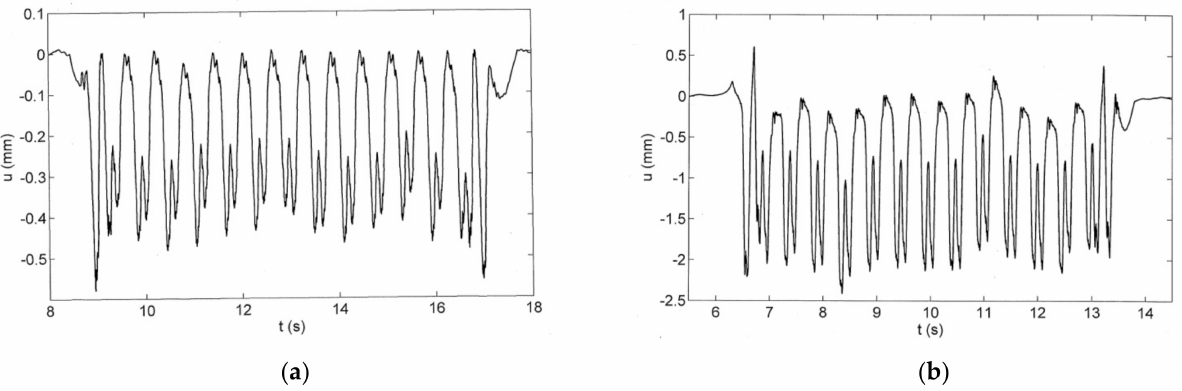
Figure 6. Measured passages of a long German ICE train with v T = 160–180 km/h over a floating-slab track with 6 m long segments at Site S: ( a ) middle of the track plate and ( b ) end of the track plate.